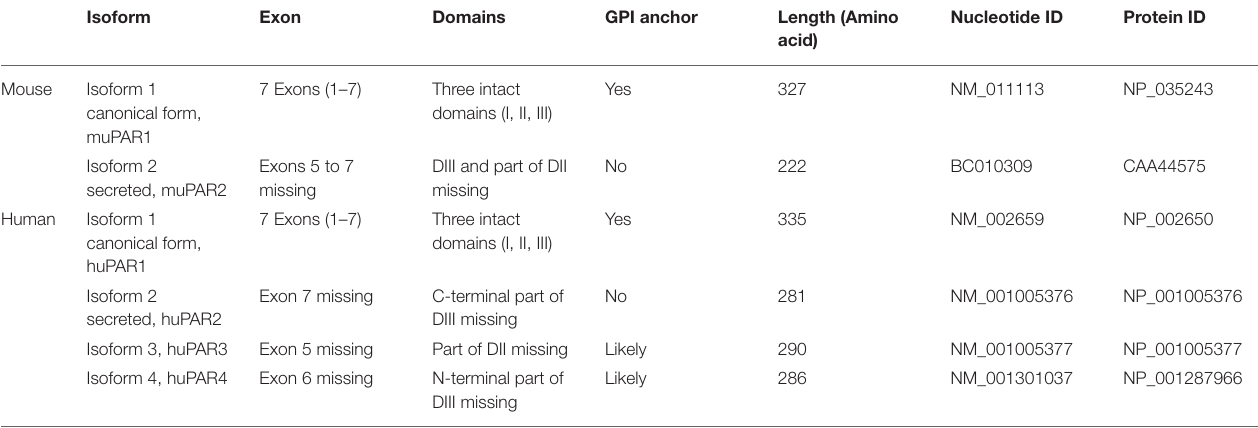
TABLE 1 | Major uPAR isoforms in mouse and human. Isoform Exon Domains GPI anchor Length (Amino